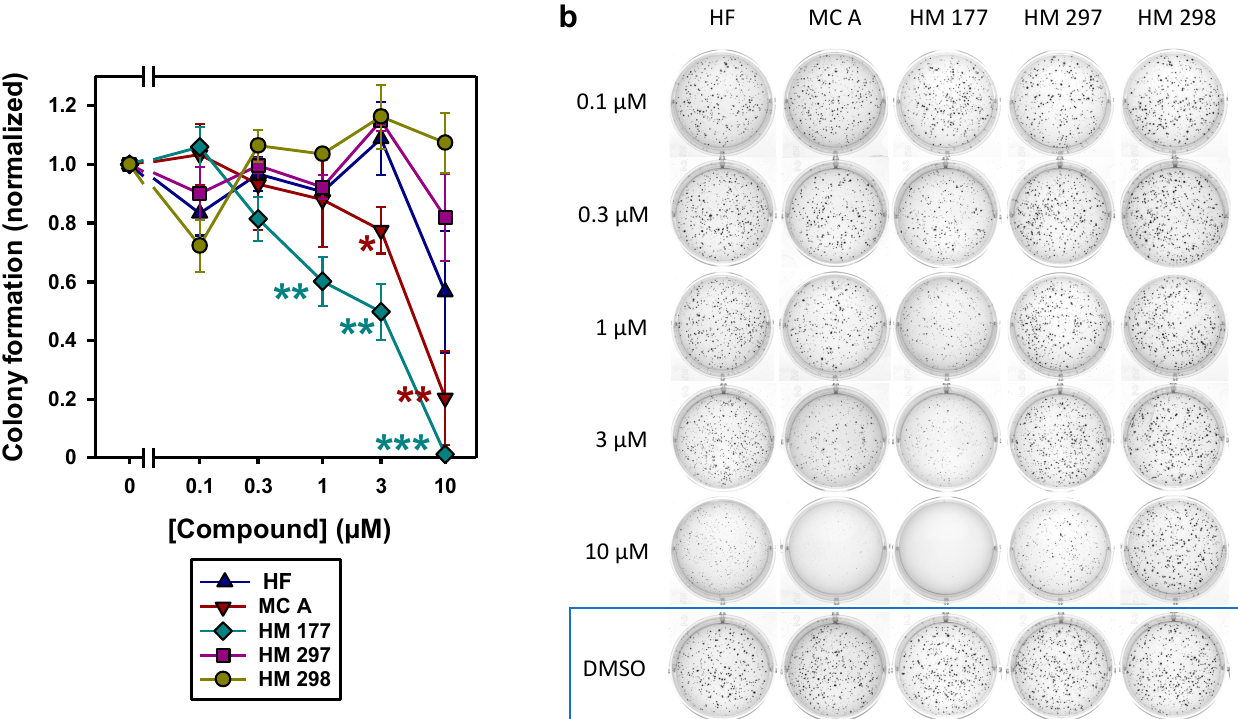
Figure 5. Anchorage-independent growth of HCT116 cells was analyzed by soft agar colony for- mation assays. HF and MCs were added at the indicated concentrations, and cells were grown for 21 days. Relative number of colonies normalized to DMSO control are shown. ( a ) Results of 3 inde- pendent experiments, each performed in triplicate, are summarized in the graph. * p < 0.05; ** p < 0.01; *** p < 0.001 (two-tailed Student’s t -test). ( b ) Images of colonies as taken from a representative experiment.